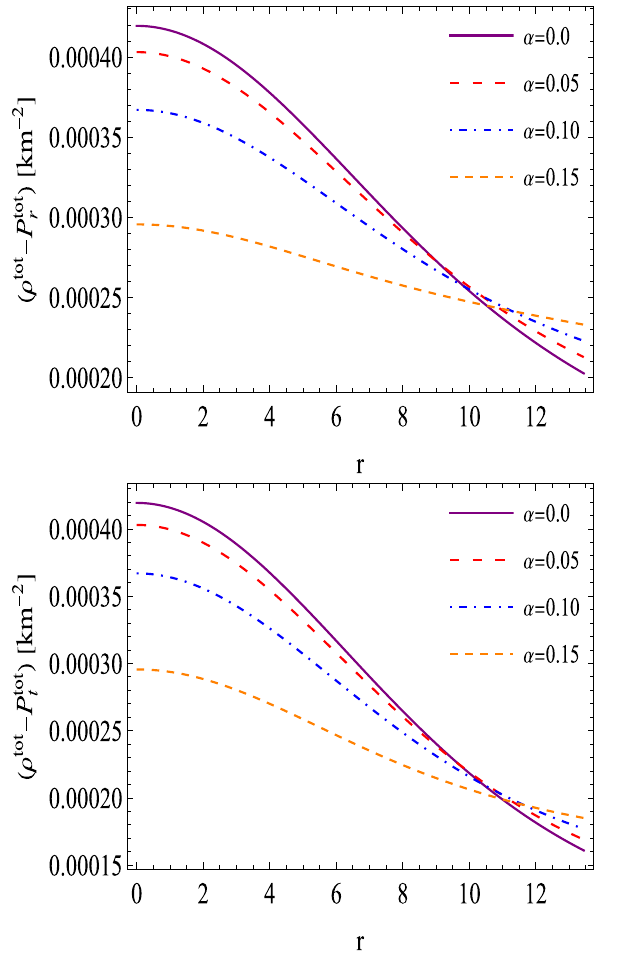
Fig. 5 The behavior of ( ρ tot − P tot r ) and ( ρ tot − P tot t ) versus radial coordinate r with same constant values as used in Fig.3